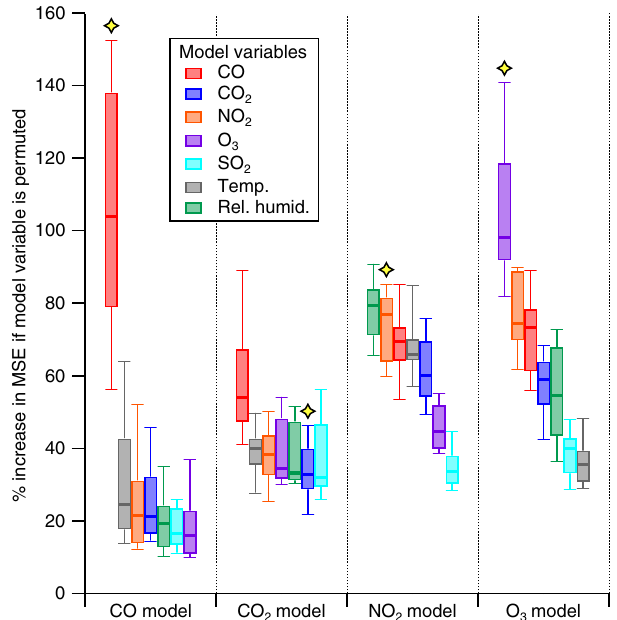
Figure 9. Importance of the explanatory variables to each of the RF models. For each model, the explanatory variables are rank-ordered from most to least important, and the sensor response correspond- ing to the target analyte is marked with a yellow star. The box plots represent the range of importance across the 10–16 RAMP moni- tors (whiskers: 10th and 90th percentile; box edges: 25th and 75th percentile). The relative importance is determined by calculating the increase in mean square error if the explanatory variable is permuted (i.e., randomly